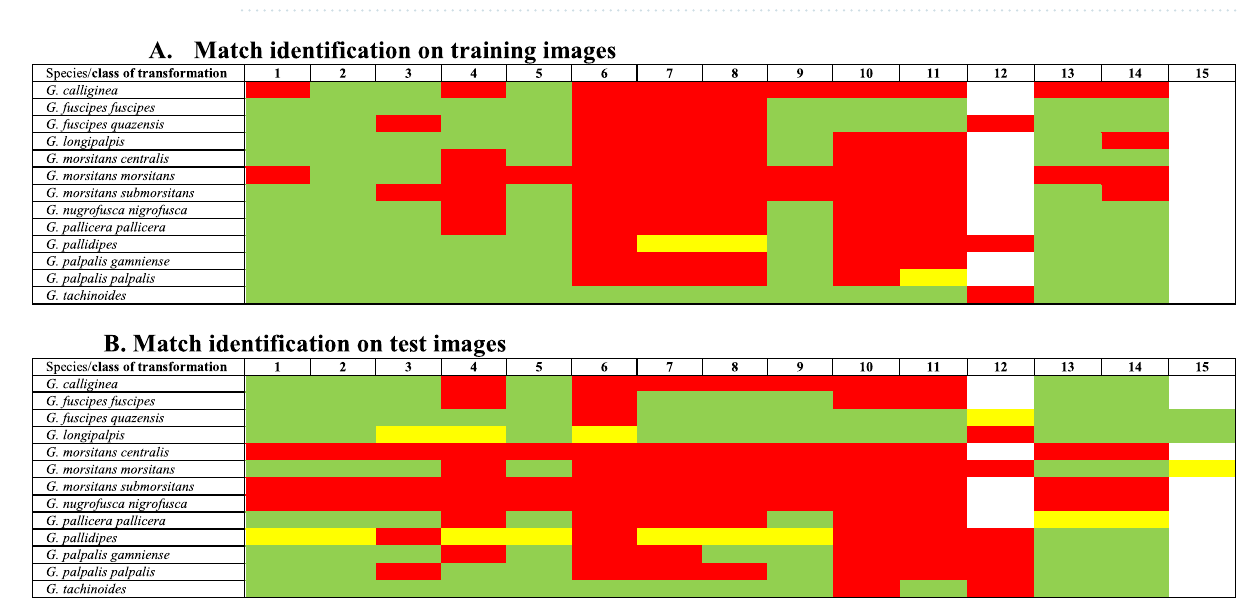
Figure 7. Misclassified picture; some examples from the images mistakenly predicted by the CNN model.